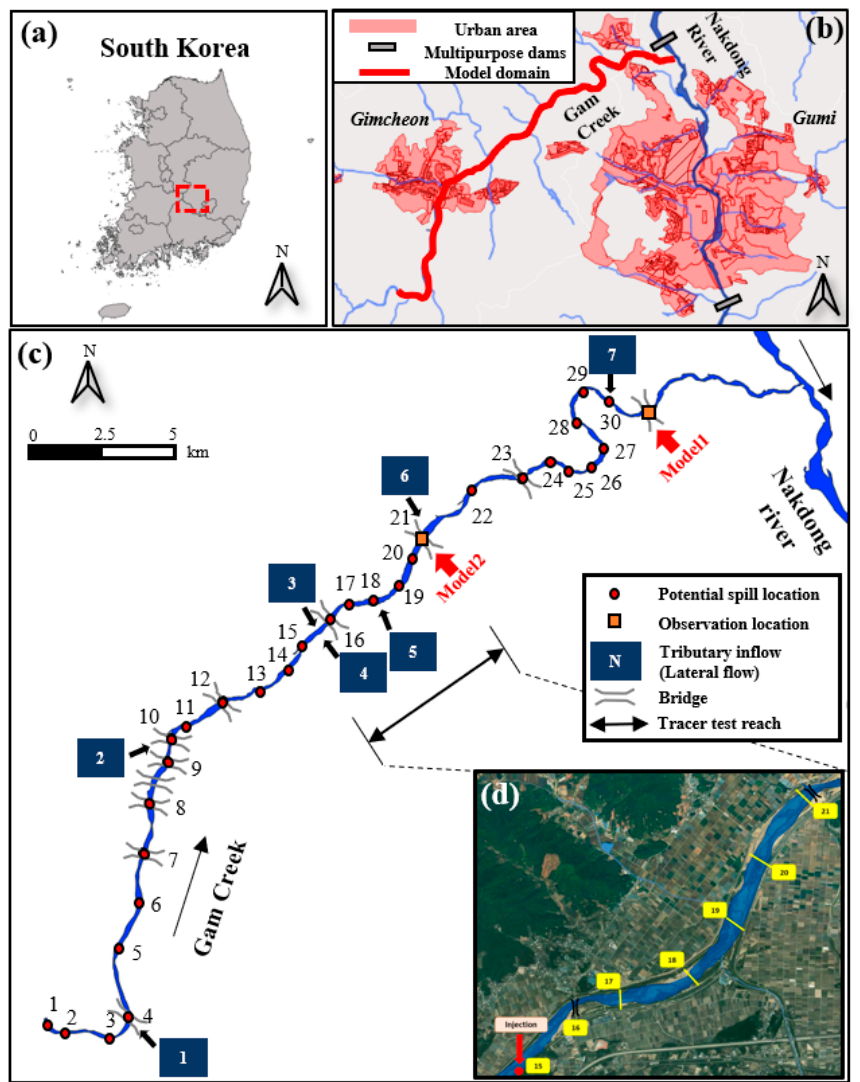
Figure 3. Site map showing ( a ) the location of the Gam creek region in South Korea; ( b ) the model domain and the location of urban areas that would potentially be subject to significant damage from the spilled contaminants near the region; ( c ) the potential spill locations and monitoring points developing ITM in the Gam Creek region; ( d ) the tracer test reach.